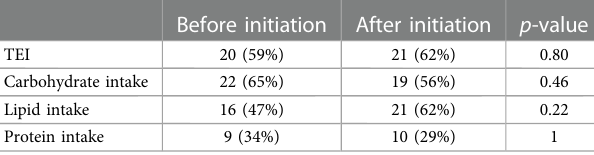
TABLE 3 Changes in compliance with nutritional recommendations after initiation of lumacaftor/ivacaftor.